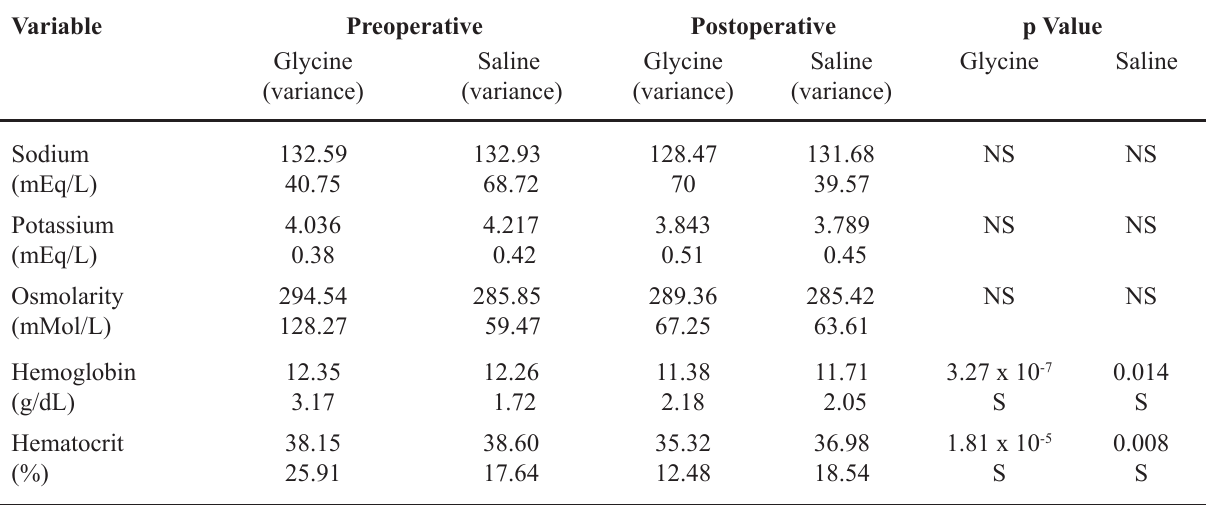
Table 2 – Comparison of electrolytes, osmolarity, hemoglobin and hematocrit between bipolar and monopolar groups.